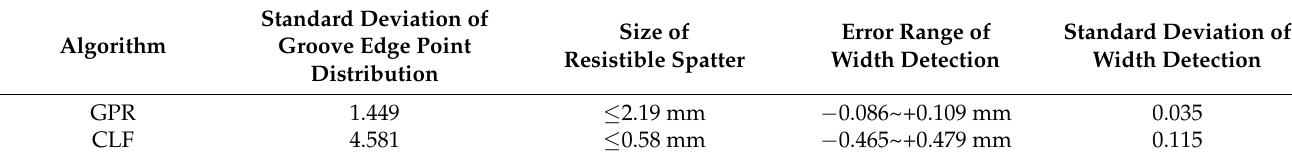
Table 3. Comparison of detection performance for constant-width